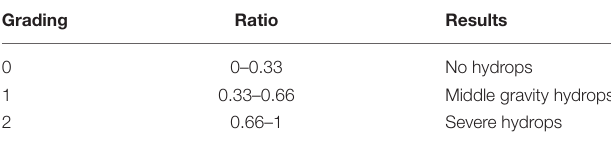
TABLE 1 | Hydrops visualization grading, represented by the ratio between the volumes of the contrast agent in the Flair 3D and TSE and T2 sequences.